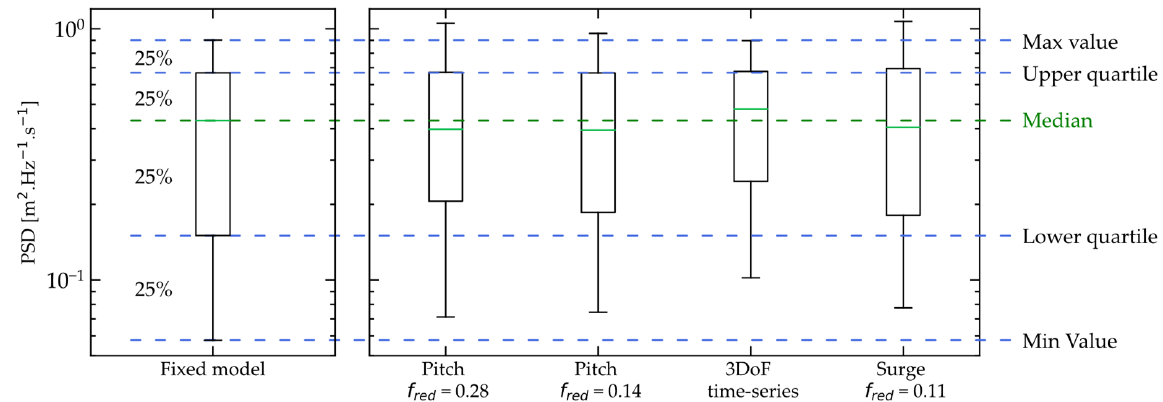
Figure 11. Box-and-Whisker plot of PSD values for y c .